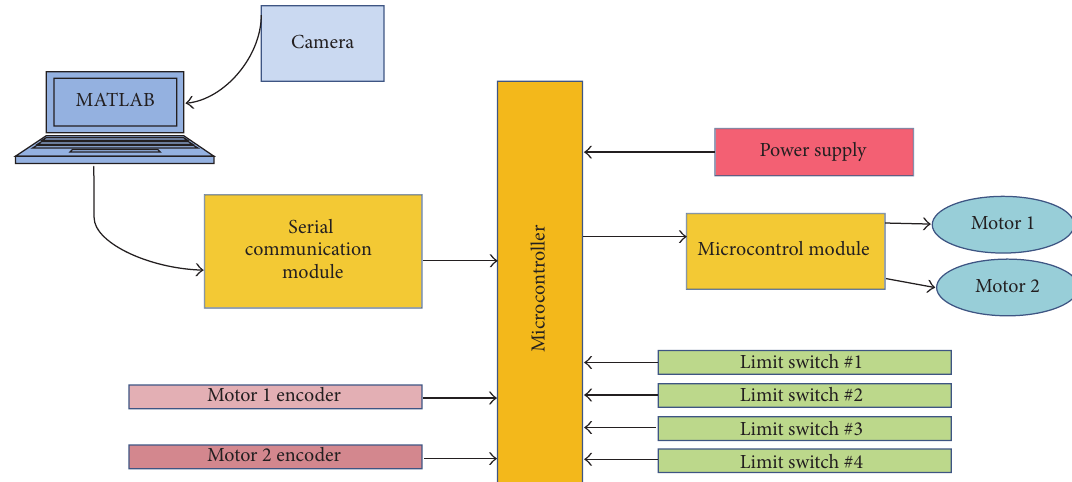
Figure 8: System electronic control with microcontroller nucleus linked with architecture.